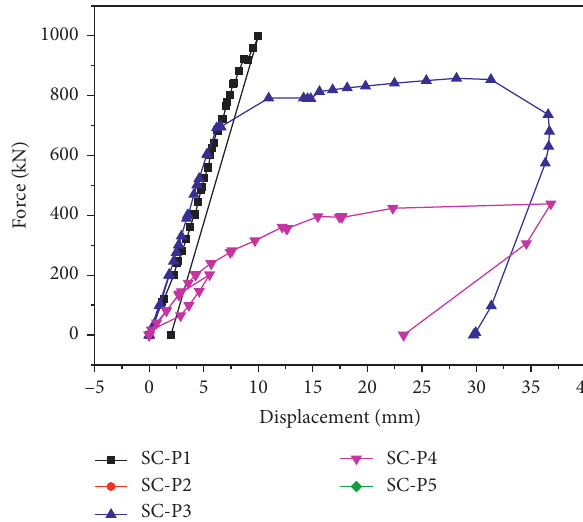
Figure 22: Load-midspan deflection curves of SC-P1, SC-P3, and